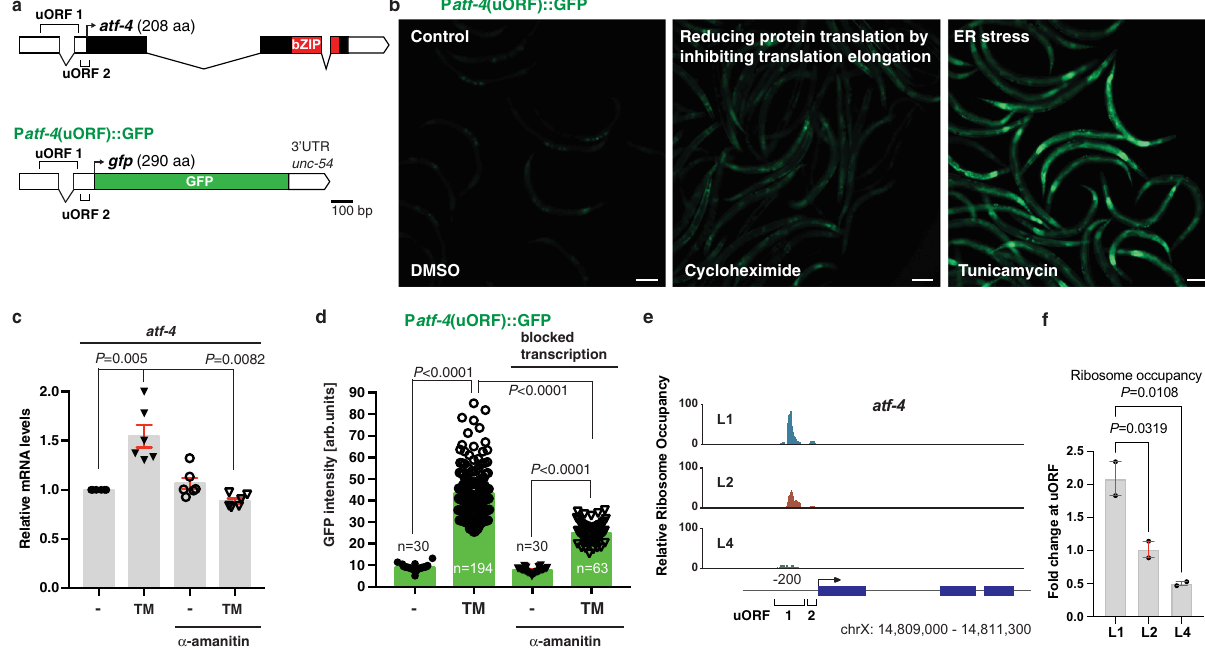
Fig. 1 ATF-4 is preferentially translated under conditions of reduced global protein synthesis. a Schematic diagram of the atf-4 mRNA and the P atf- 4 (uORF)::GFP reporter. UTRs are represented as empty boxes, exons as fi lled boxes, and the basic leucine zipper domain (bZIP) in red. b Representative images showing that reducing translation by administering 7.2 mM cycloheximide for 1 hour or 35 μ g/ml tunicamycin (TM) for 4 h increased expression of transgenic P atf-4 (uORF)::GFP in L4 stage animals. Quanti fi cation of GFP fl uorescence intensity is shown in Supplementary Fig. 1c. Scale bar = 100 μ m. c